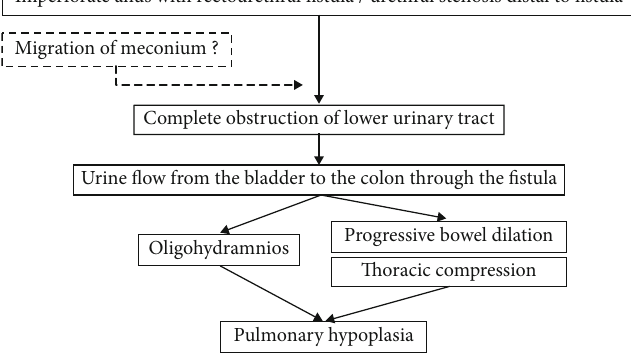
Figure 4: Schematic of the proposed mechanism of pulmonary hypoplasia in our case. The narrow urethra may have been obstructed due to fetal meconium, which may have passed from the colon into the urethra through the fi stula, resulting in complete obstruction of the lower urinary tract in the fetus with urethral stenosis. Urethral obstruction directed the urine fl ow from the bladder through the rectourethral fi stula to the colon, causing oligohydramnios and progression of bowel dilation, resulting in pulmonary